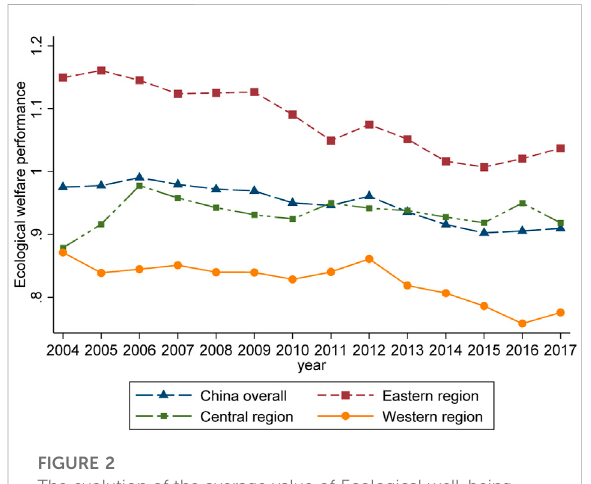
FIGURE 2 The evolution of the average value of Ecological well-being performance in China and the three major regions.